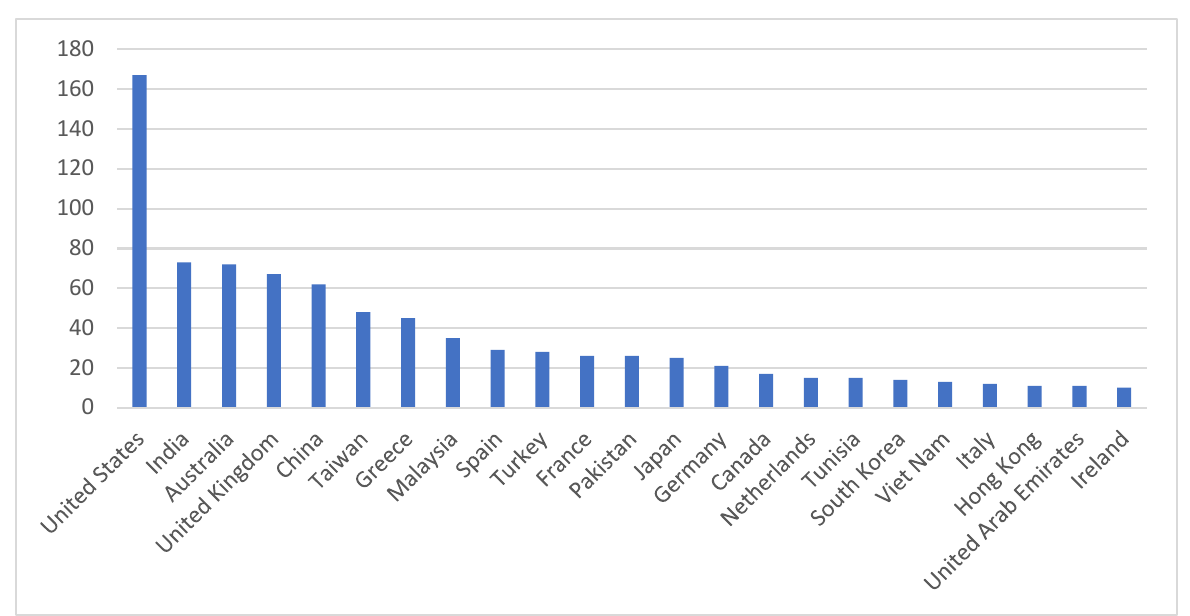
Figure 3. Leading Countries. Source: Elaborated by authors using data extracted from Scopus.